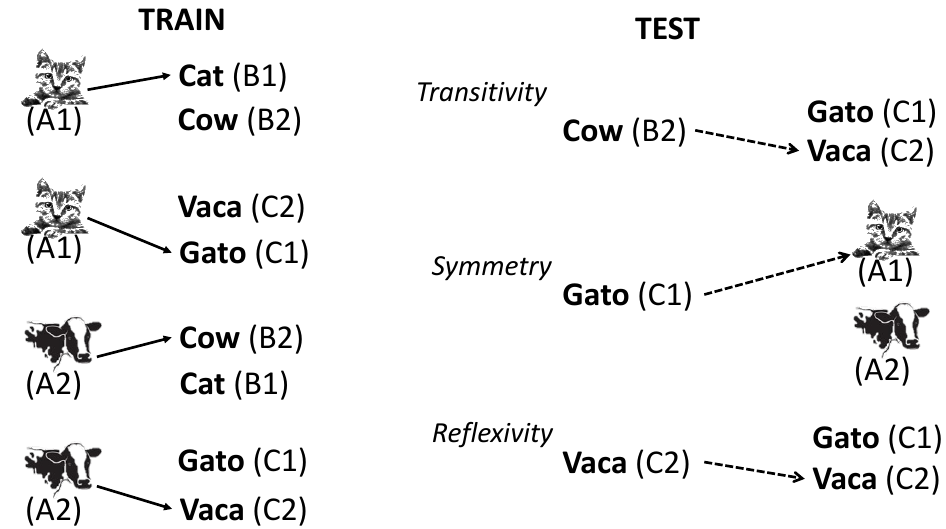
Figure 1. Example of 2 stimulus classes (1 and 2) with 3 members (A, B, and C). The left part displays the training phase, and the right part corresponds to transitivity symmetry and the reflexivity